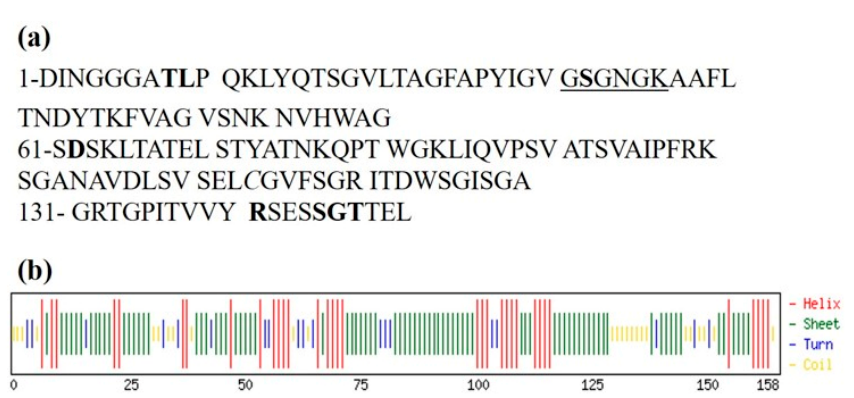
Figure 6. Partial amino acid sequence of PARPSso. ( a ) Amino acids defining the phosphate binding (P)-site are in bold. PARPSso accession number B3EWG9 (UniProt). The Walker A motif is underlined. ( b ) Prediction of secondary structure of PARPSso [23]. The predicted secondary structure of this region indicates the cluster of beta-sheets flanked by alfa-helices described for other DING proteins.